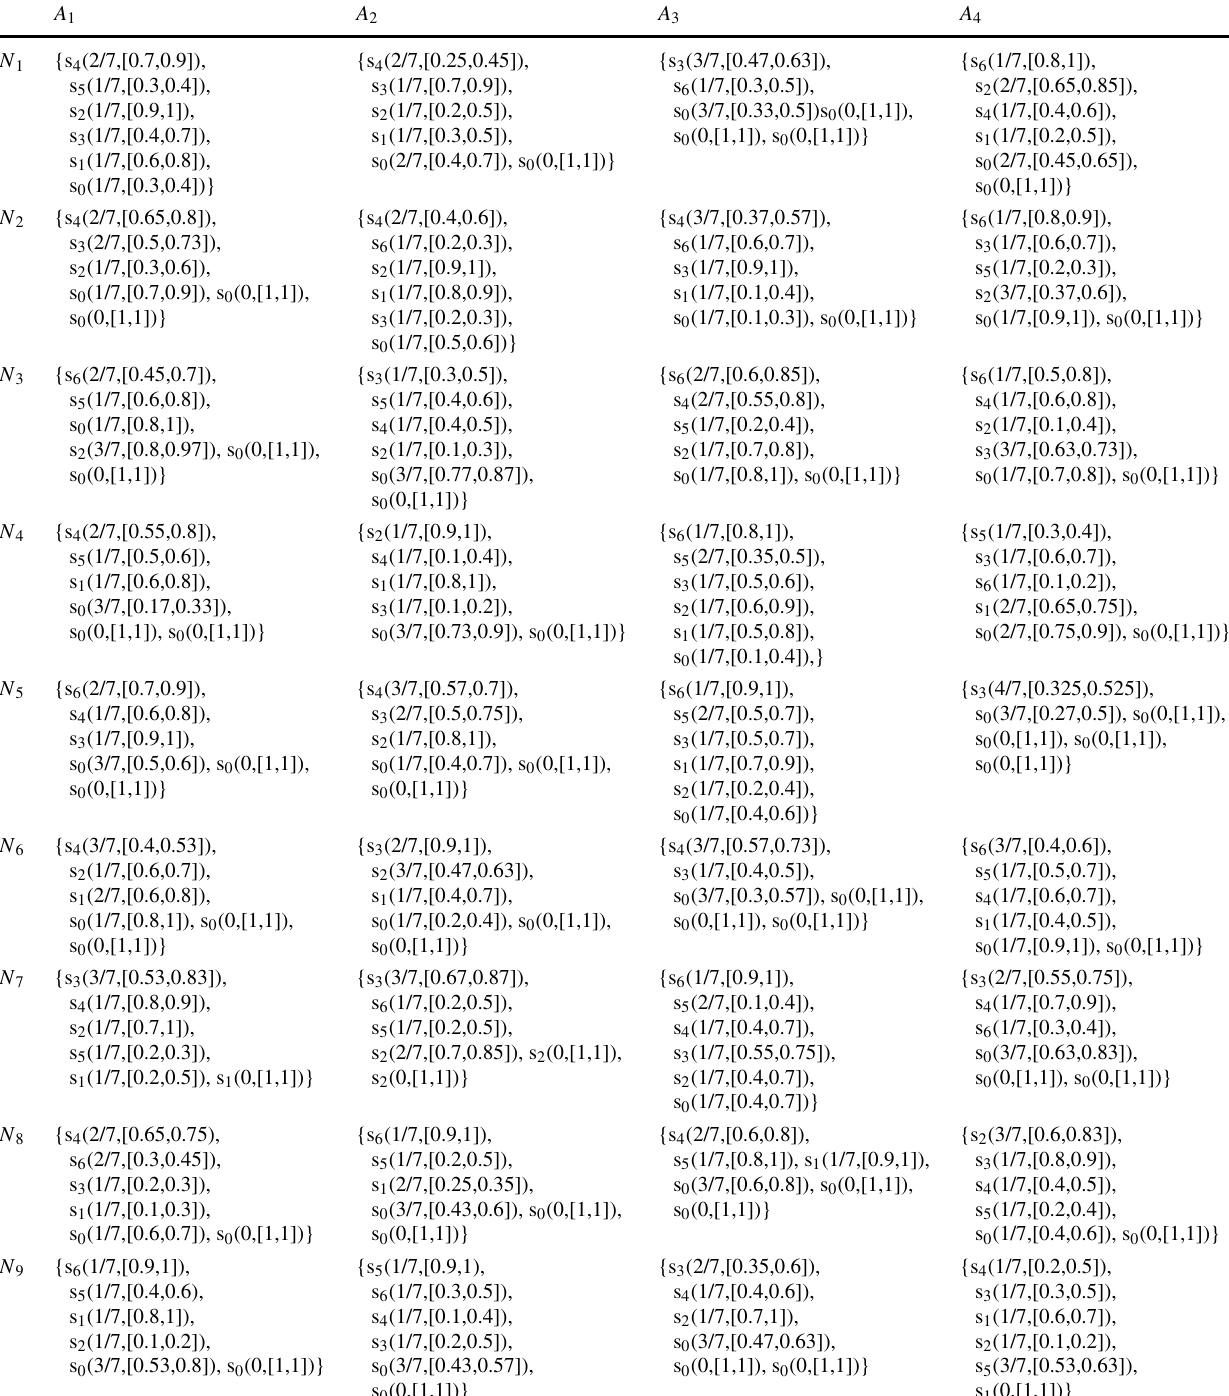
Table 9 The normalized decision matrix of voting for primary node election A 1 A 2 A 3 A 4 N